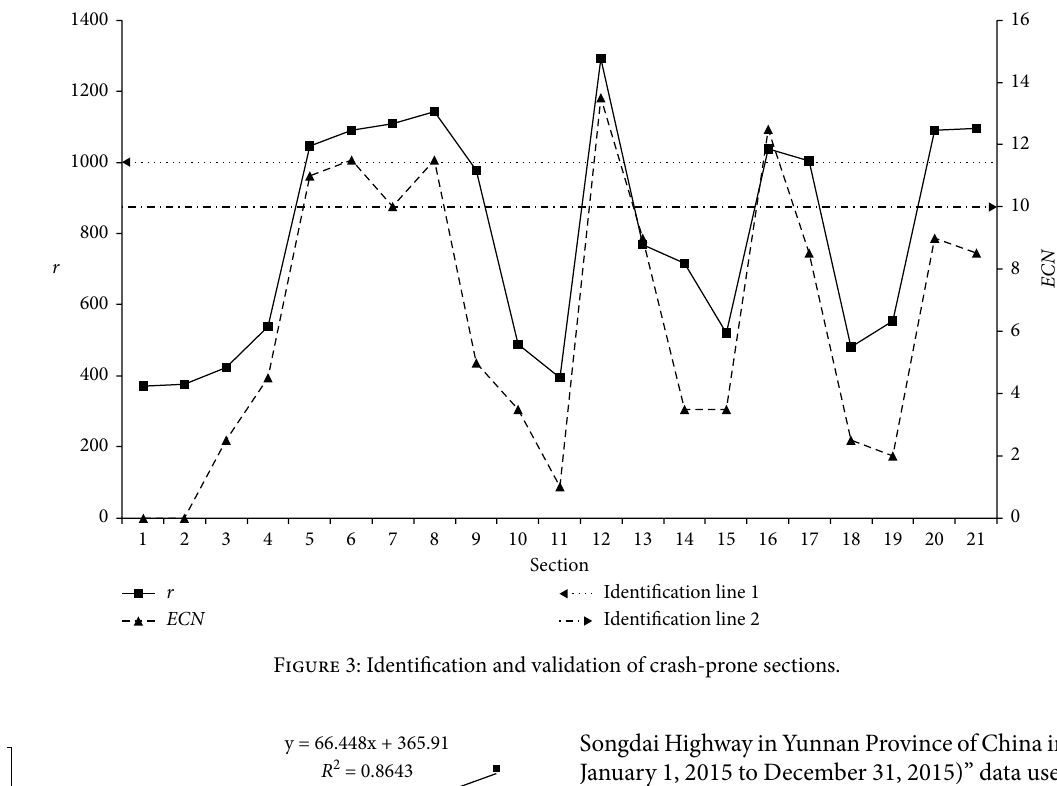
Figure 3: Identification and validation of crash-prone sections.